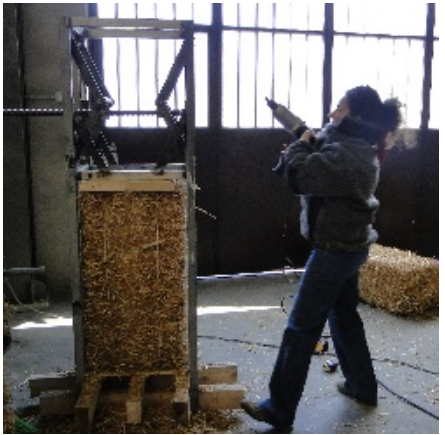
Figure 13. Pre-stressed straw bale.